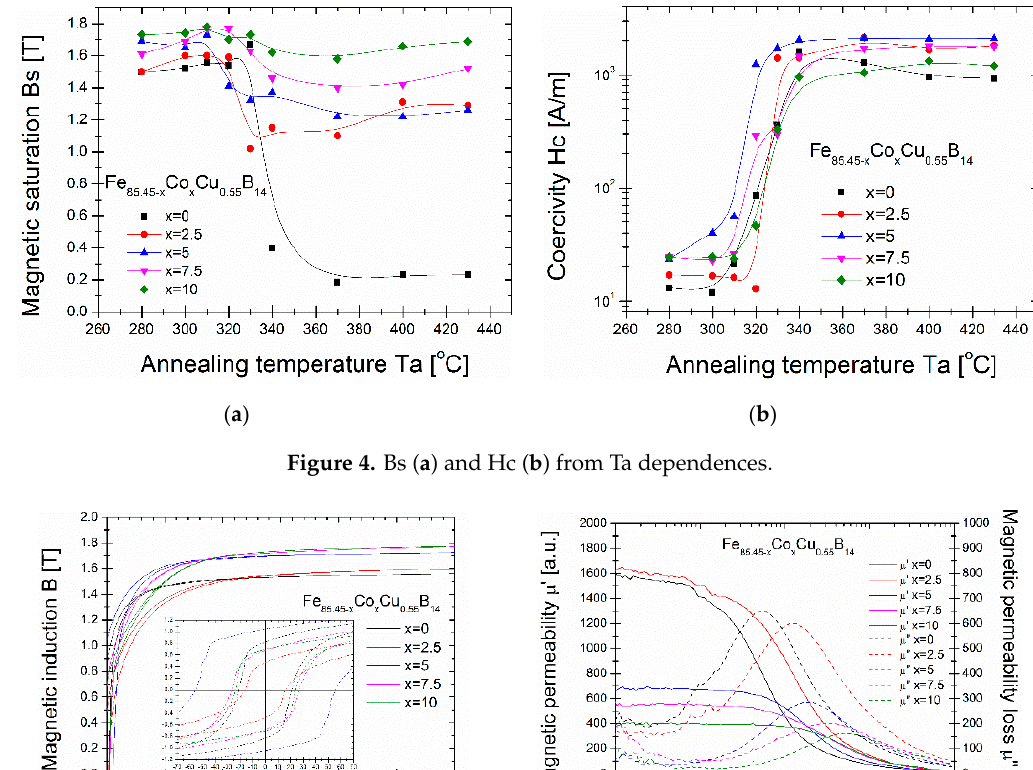
Table 1. Core power losses for annealed at 310 °C toroidal cores measured at 1 T/50 Hz (P10/50), 1.5 T/50 Hz (P15/50), saturation magnetization Bs and coercivity Hc.